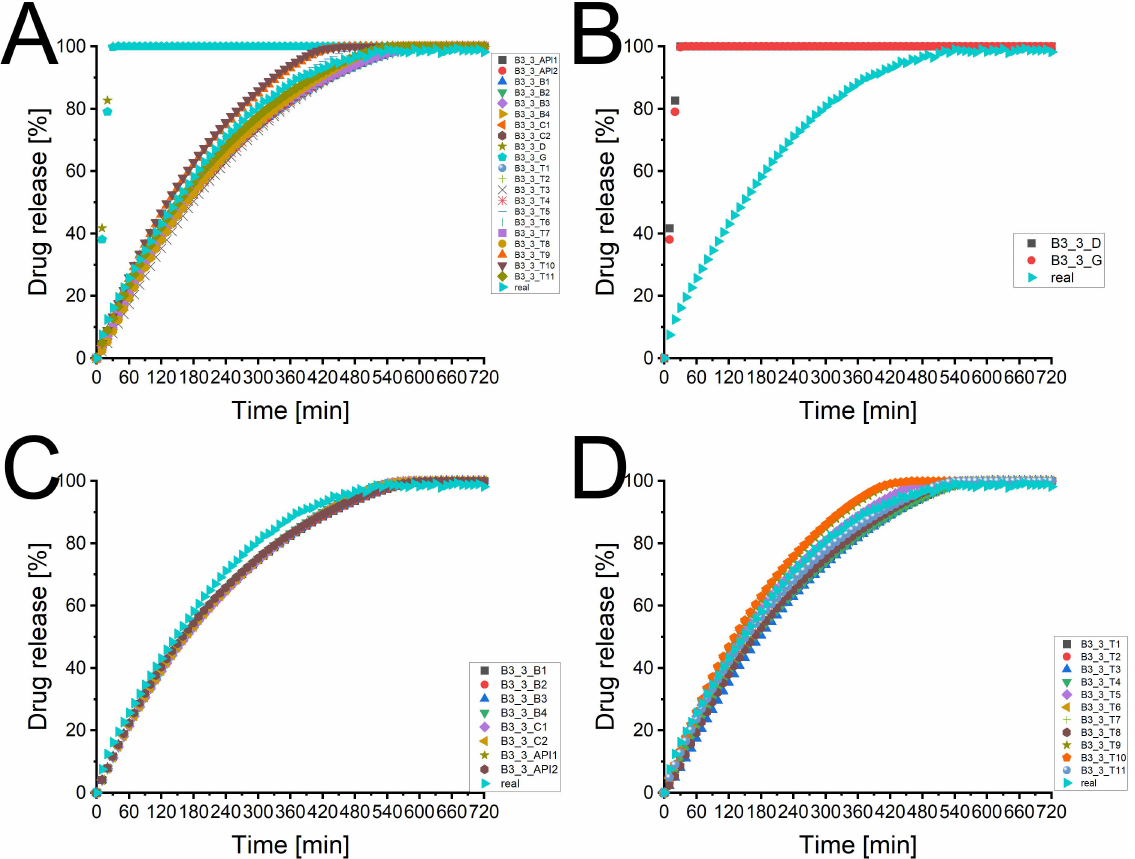
Figure 7. The predicted dissolution profiles of different image processing pathways of the imaged tablet 3 of batch T75E25 ( n = 1). The experimental determined dissolution profile is depicted as well. ( A ) Overview of all dissolution profiles of the imaged tablet 3 of batch T75E25. CAVE: only the symbol and colour of the experimental curve remains always the same. ( B ) Comparison of experimental dissolution profile and both types of virtual tablets produced by the PAC-module. ( C ) Comparison of experimental dissolution profile and virtual tablets based on X µ CT images (API-, combination-, and batch specific pathways). ( D ) Comparison of experimental dissolution profile and virtual tablets based on X µ CT images (tablet specific